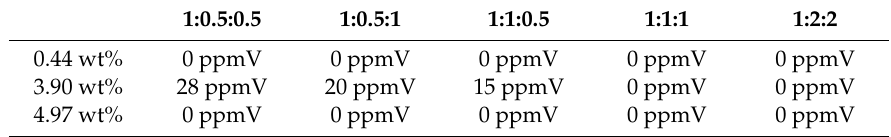
Table 3. Comparison of maximum concentration of formed C 2 H 4 with illumination time among di ff erent molar ratios of CO 2 / H 2 / H 2 O and Pd loading weight with UV light illumination.